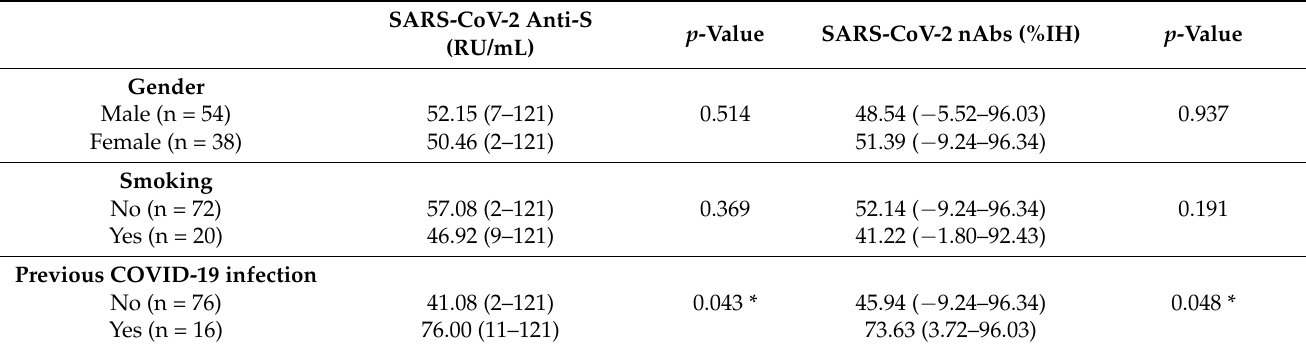
Table 4. Quantitative analysis of SARS-CoV-2 anti-S titers and nAbs IH% in relation to the character- istics of 92 Sinopharm vaccine